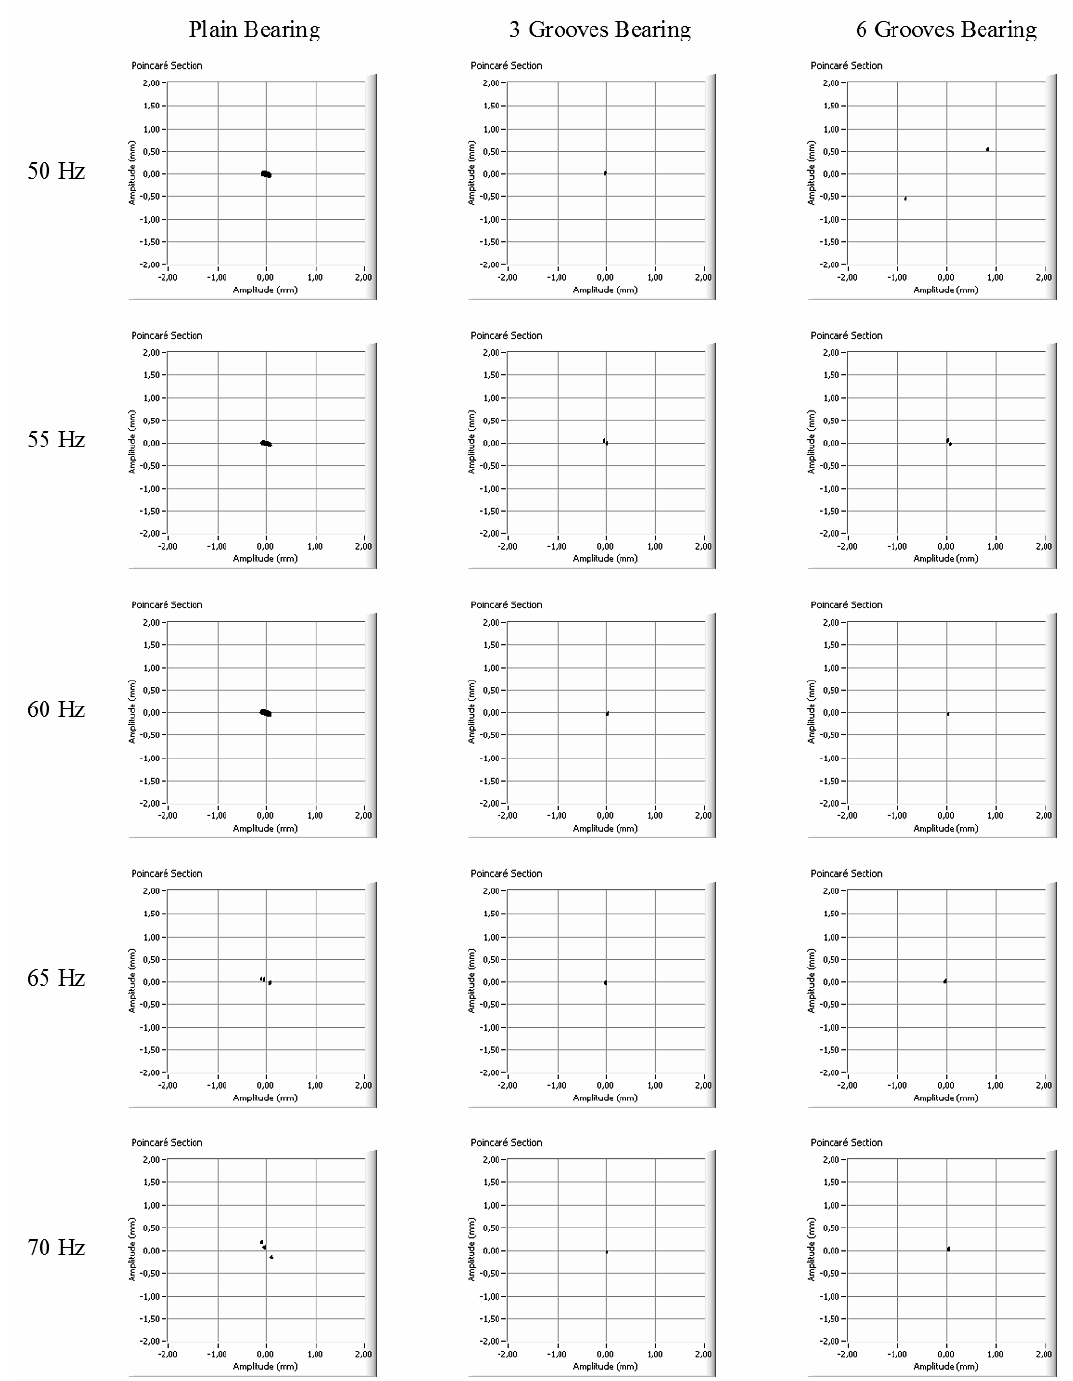
Fig. 14. Results – Poincar ´ e map